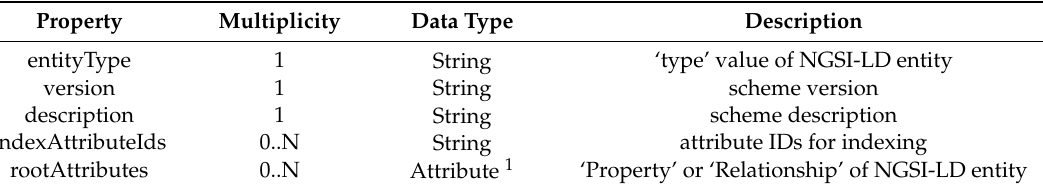
Table 1. Dynamic schema description notation.